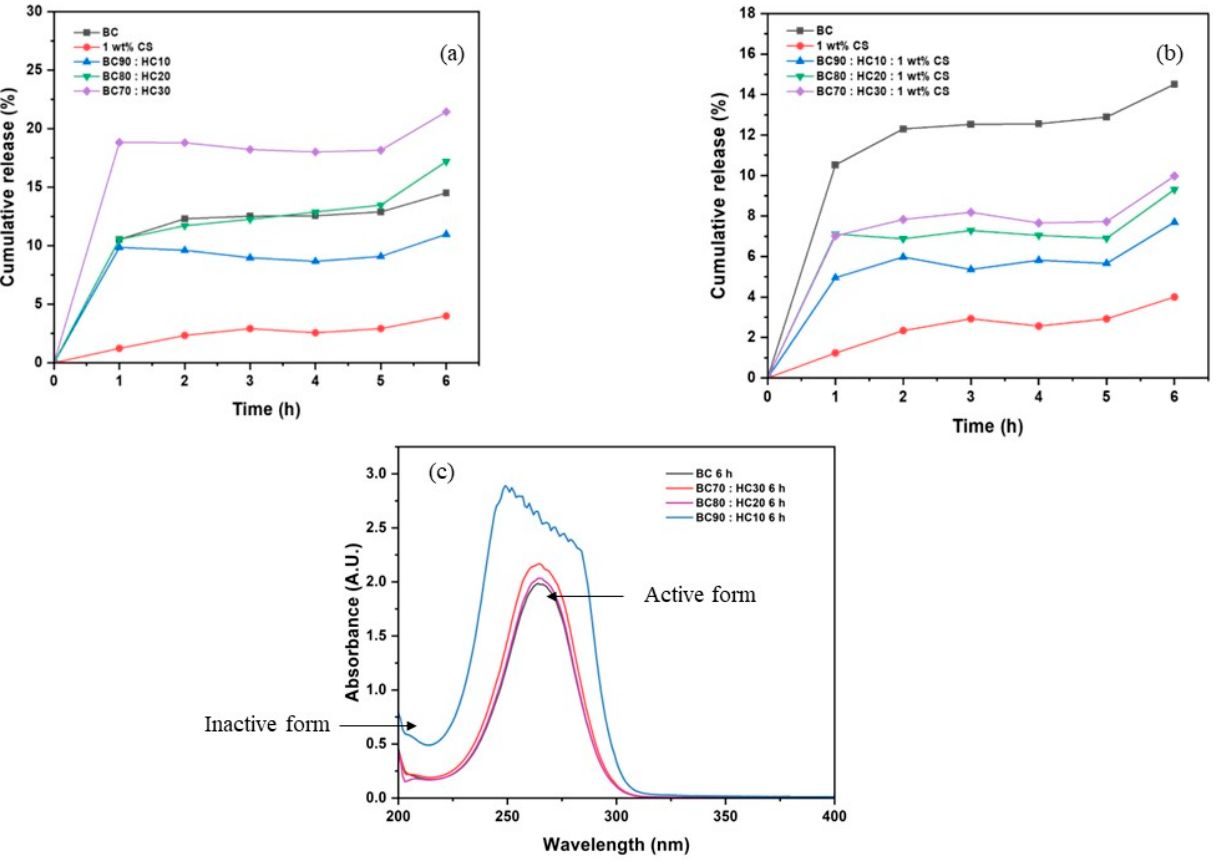
Figure 8. The percent cumulative release of ( a ) BC, CS, BC70:HC30, BC80:HC20, BC90:HC10 films, ( b ) 1 wt% CS-coated BC:HC films, and ( c ) UV/Vis spectra of ascorbic acid.